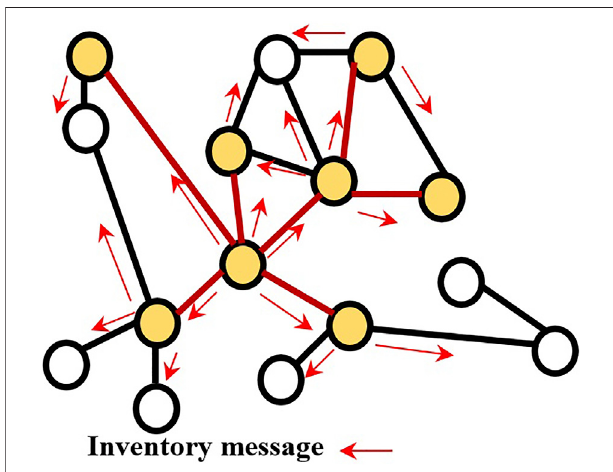
FIGURE 1 | Information propagation in a permission-less blockchain such as Bitcoin. Colored nodes are the nodes that have already received the block/transaction. Colored links are the links that have been used for transferring block/transaction. Each link will carry at least one inventory message, but some of them will carry